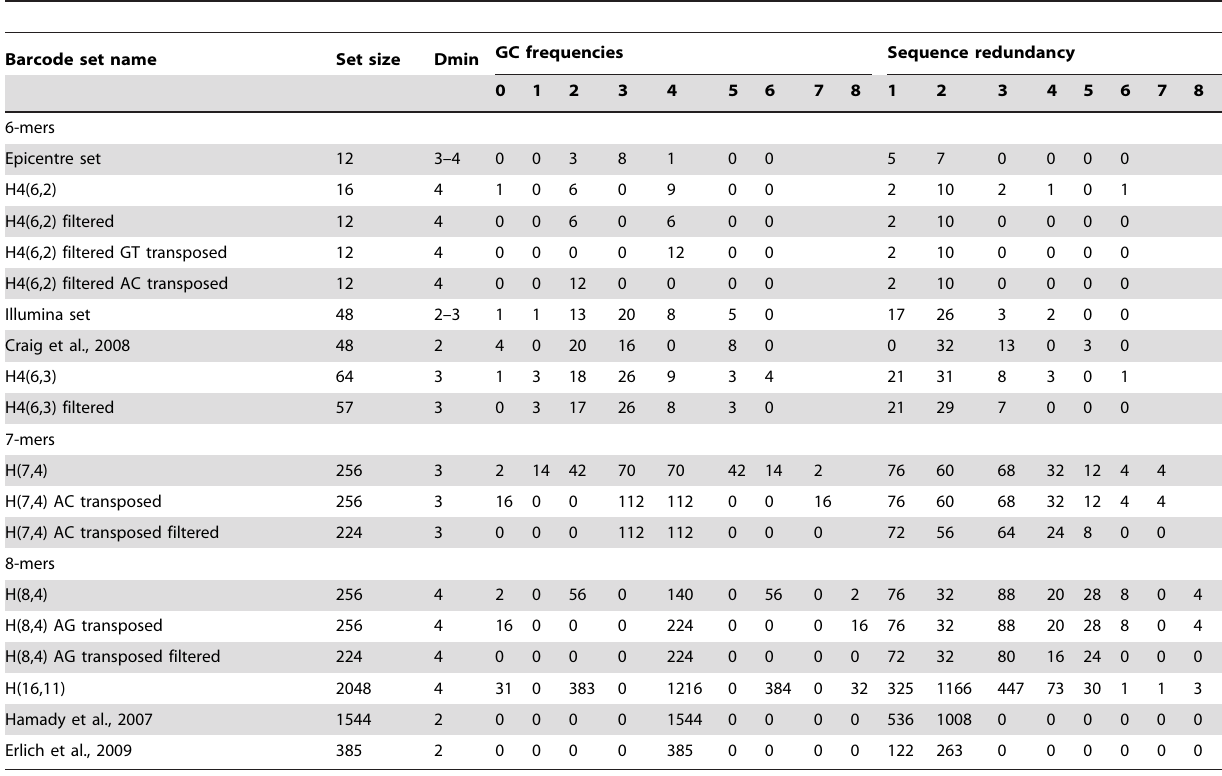
Table 4. Comparison of commercially available and quaternary Hamming based